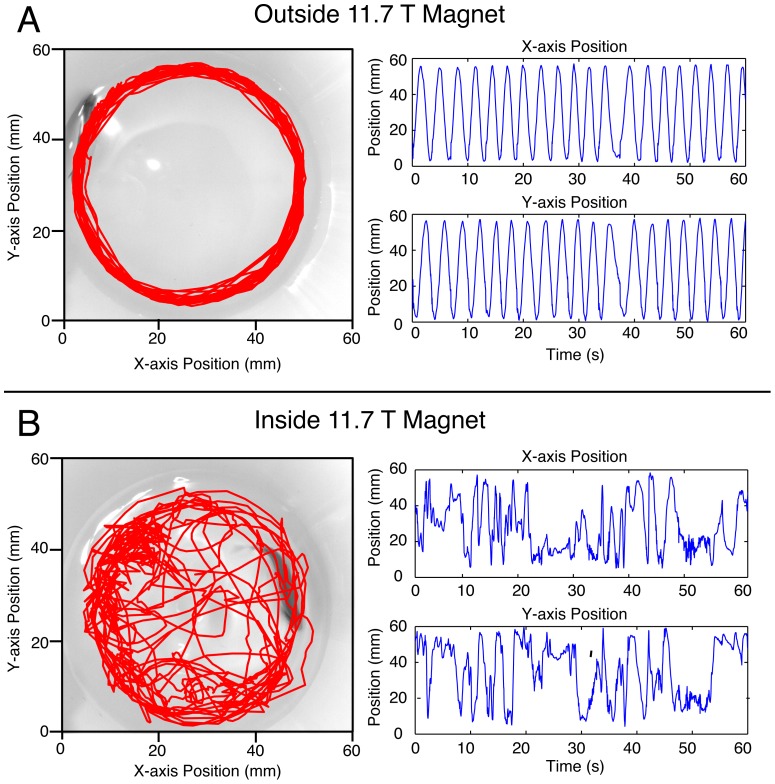
Adult zebrafish behavior outside and inside of an 11.7 T vertical magnetic field.Tracing of adult zebrafish path in visible green light during 1 minute prior to magnetic field entry (a) and during 1 minute inside the magnet (b). X- and y-position coordinates are displayed as a function of time. Upon entry into the magnet, fish swimming becomes erratic, with frequent rolling, tight circling and increased swimming velocity.